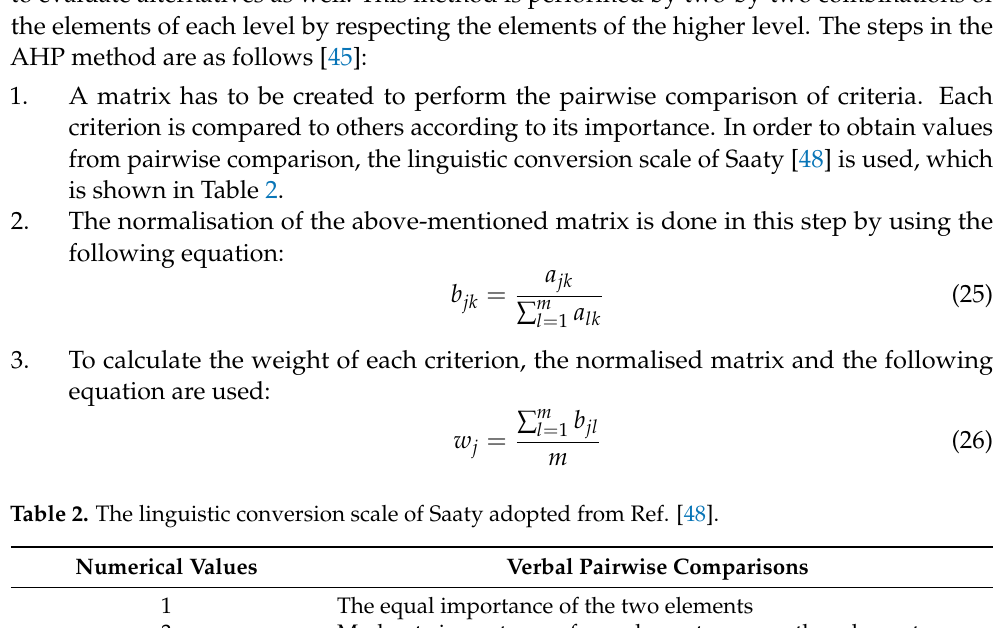
Table 2. The linguistic conversion scale of Saaty adopted from Ref. [48]. Numerical Values Verbal Pairwise Comparisons 1 The equal importance of the two elements 3 Moderate importance of one element over another element 5 Strong importance of one element over another element 7 Very strong importance of one element over another element 9 The extreme importance of one element over another element 2, 4, 6, 8 Intermediate